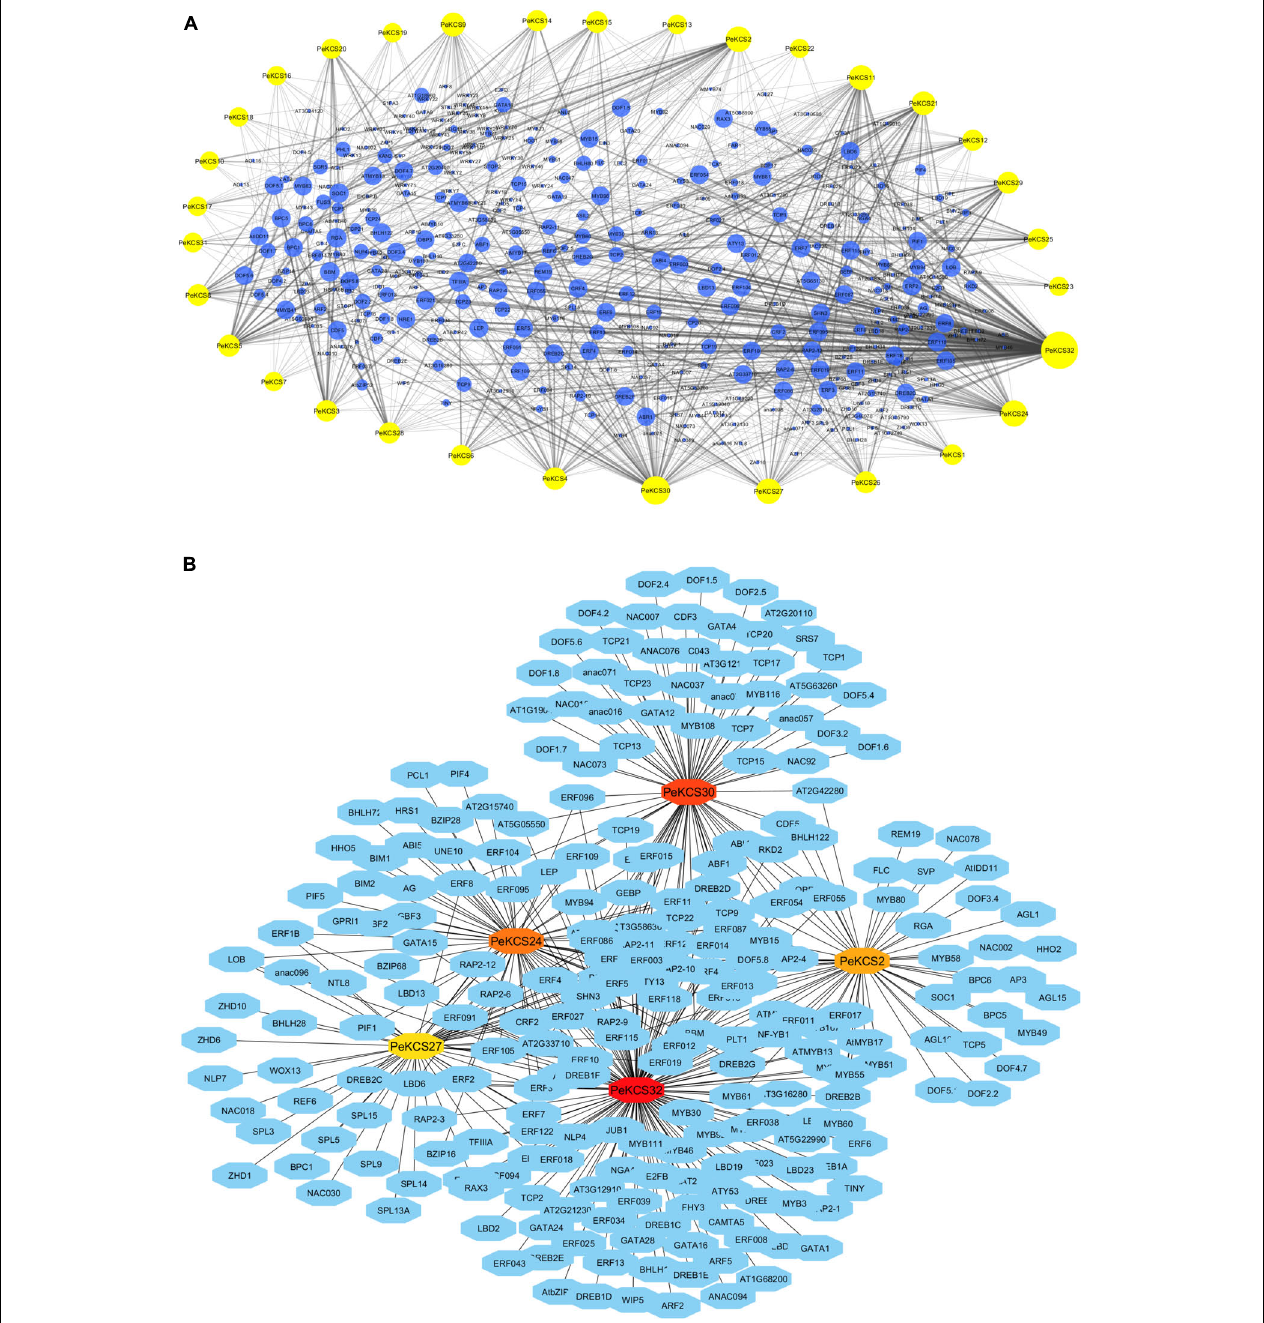
FIGURE 8 | The putative transcription factor regulatory network analysis of PeKCS genes. (A) Bluish circular nodes represent transcription factors; yellow octagonal nodes represent PeKCS genes and node size represents the degree of interaction between nodes based on degree value. (B) The top 5 highly enriched and targeted PeKCS genes are shown, darker the color shows highly enriched. Transcriptional factors were predicted by PTRM online program and regulatory network was constructed using the Cytoscape 3.9 software.